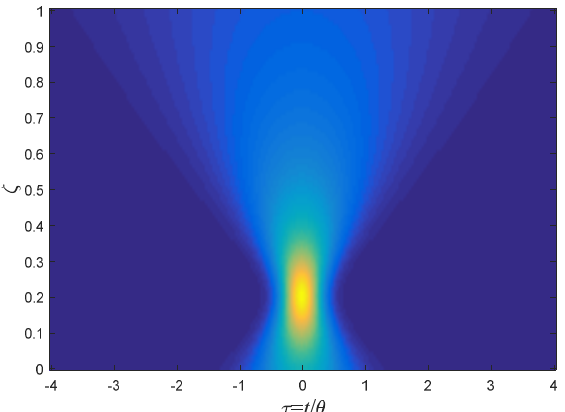
  2 , ztA ) of the pulse presented by Equation (18) (in